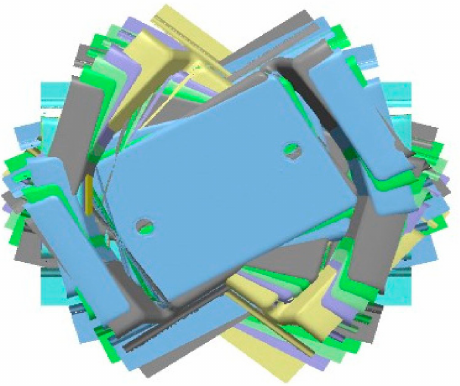
Figure 3. Overlapping scattered original point cloud data.